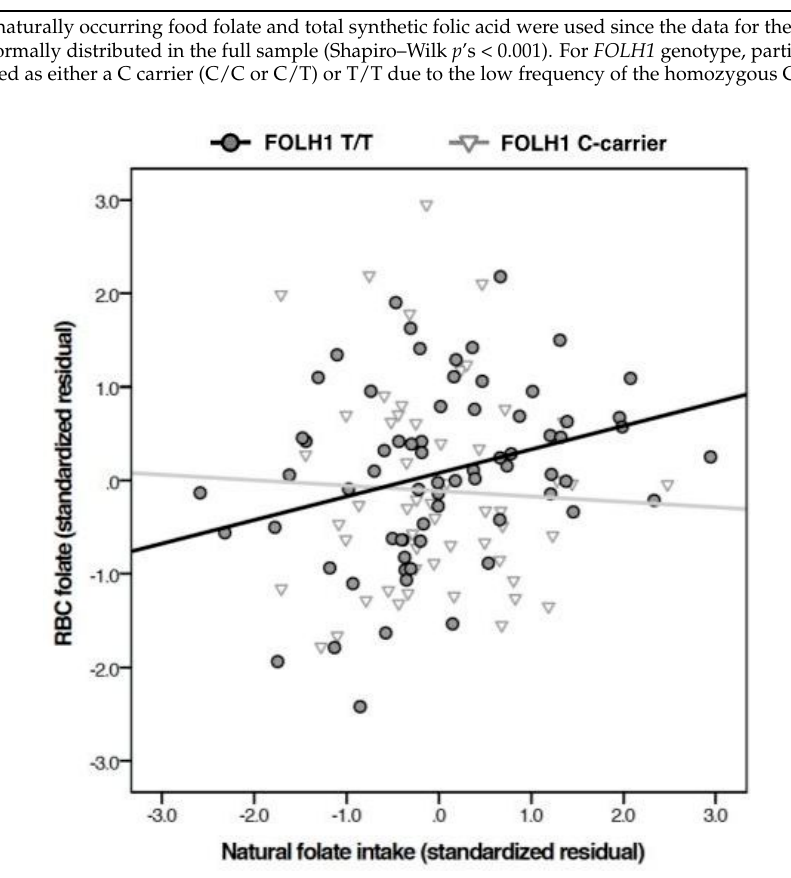
Figure 1. Interactive effect of food folate intake and FOLH1 genotype on blood RBC folate levels for Caucasian participants. Naturally occurring food folate intake correlated positively with RBC folate level only among individuals homozygous for the 484T allele (interaction p = 0.043). Table 5. Caucasian stratified predictors of RBC folate via hierarchical linear regression ( n = 123).